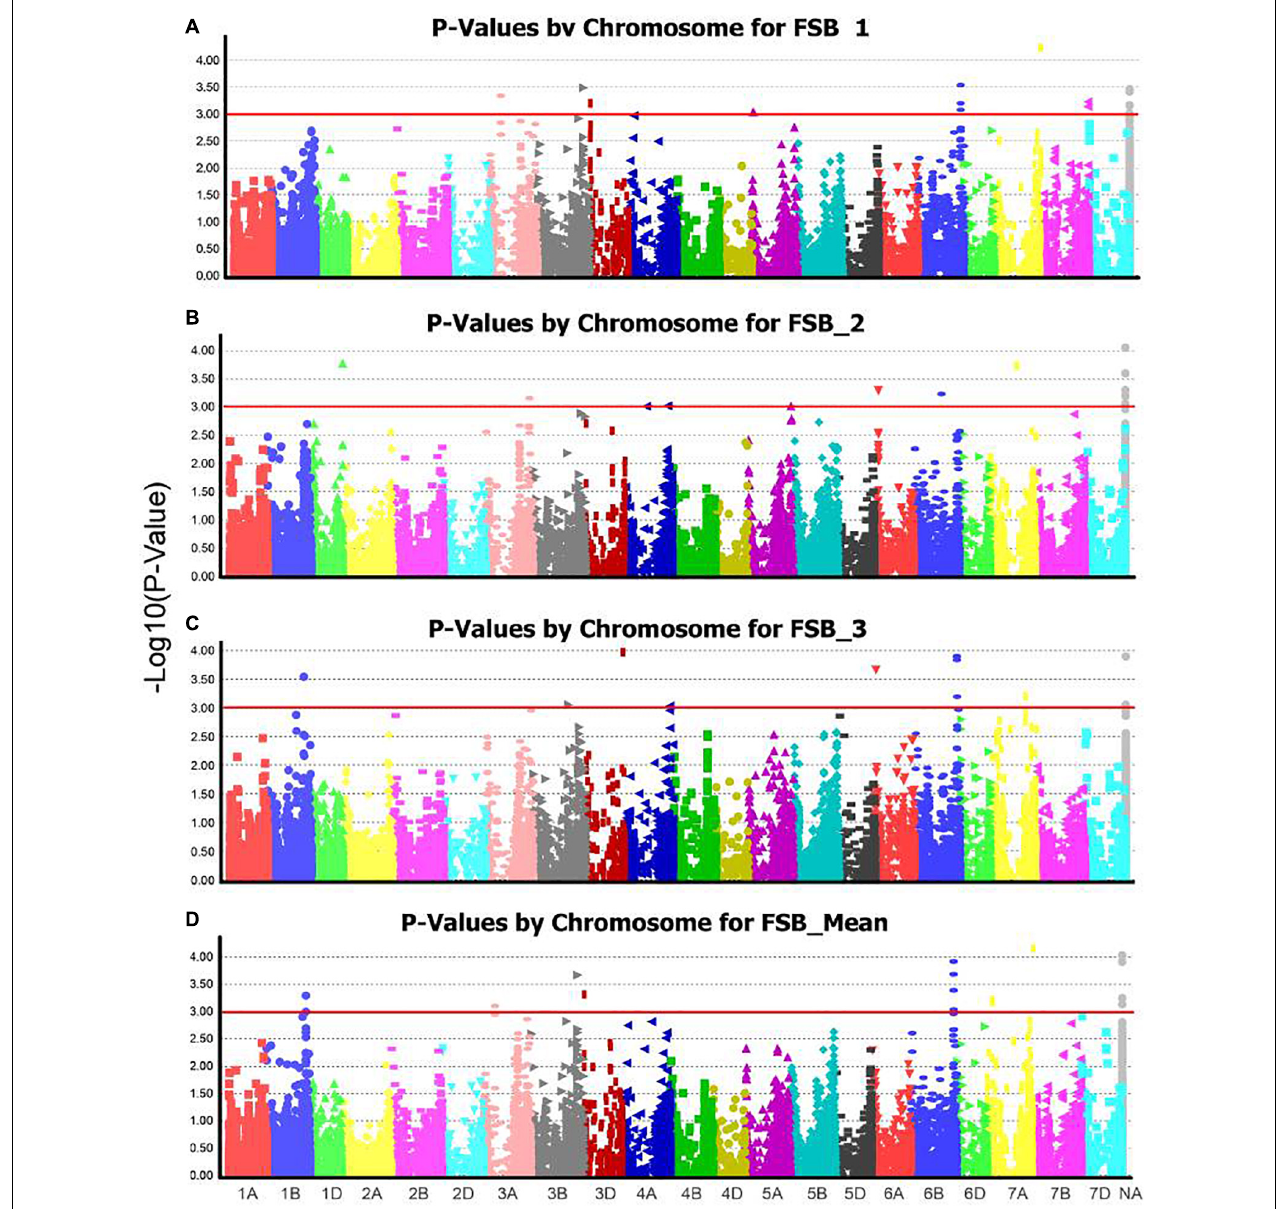
FIGURE 2 | Manhattan plots from genome-wide association scan for Fusarium seedling blight (FSB) severities among 240 wheat accessions in (A) FSB_Rep1, (B) FSB_Rep2, (C) FSB_Rep3, and (D) FSB_mean. Dashed red horizontal line is the significant threshold